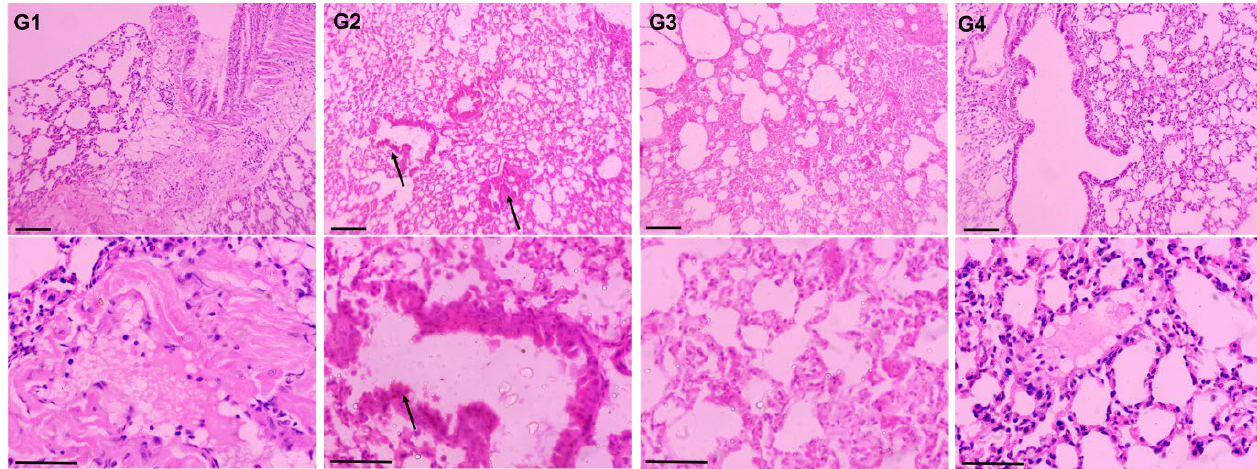
Figure 9. Effect of AAE on BaP-mediated carcinogenesis in lungs by histopathological studies. UP, 100× magnification, bar = 100 µm; LP, 400× magnification, bar = 50 µm.